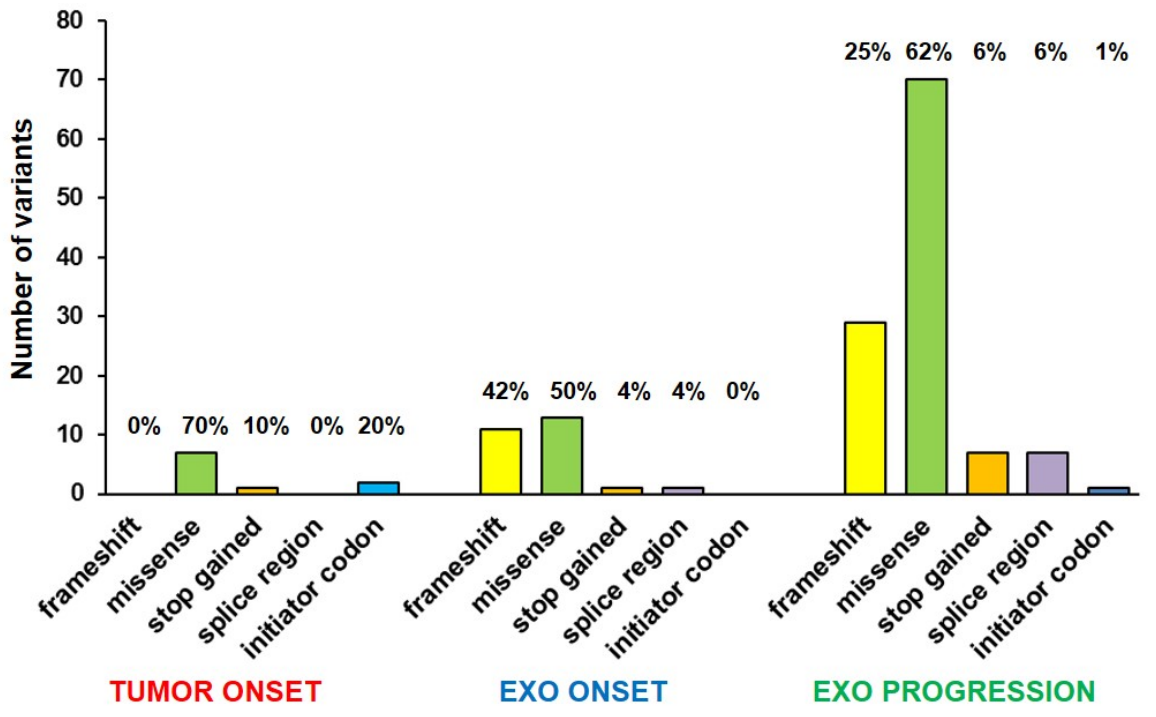
Figure 5. Mutation types in tumor DNA and in exo-DNA. Percentages are calculated on the total number of mutations present in each sample. Table 2. Genes displaying copy number variations